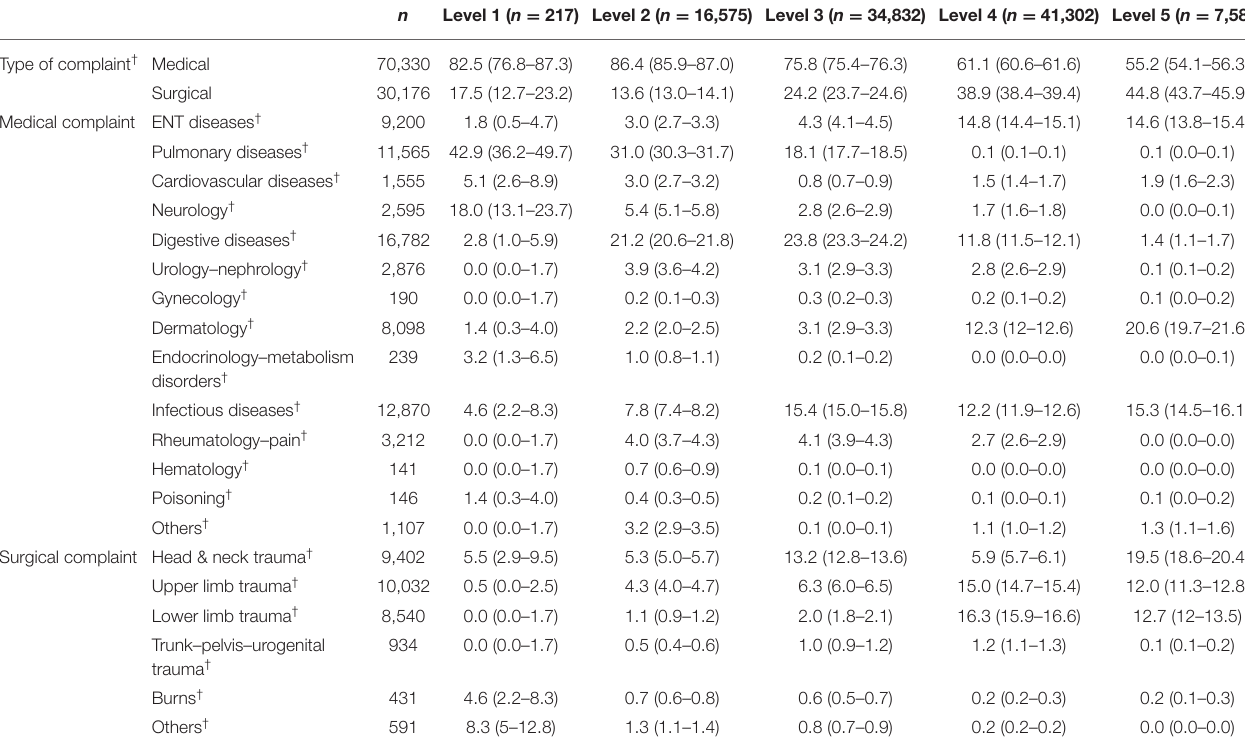
TABLE 2 | Characteristics of complaints by level of triage.